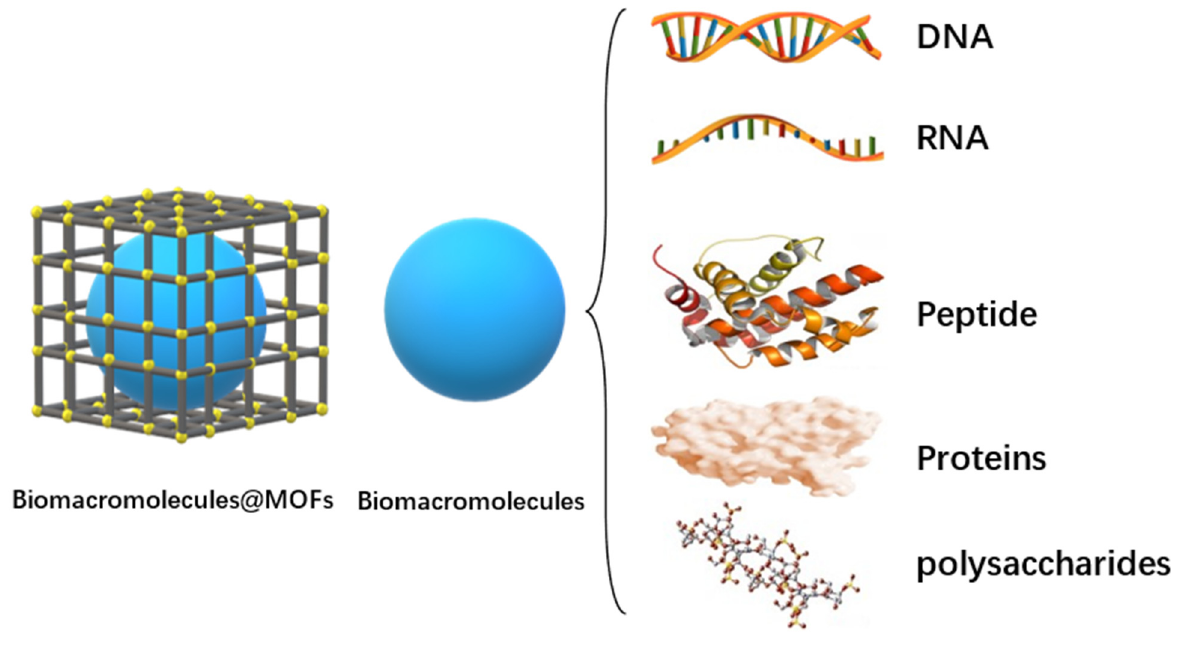
Figure 28. Morphology diagram of biomacromolecules@MOFs and biomacromolecules types.